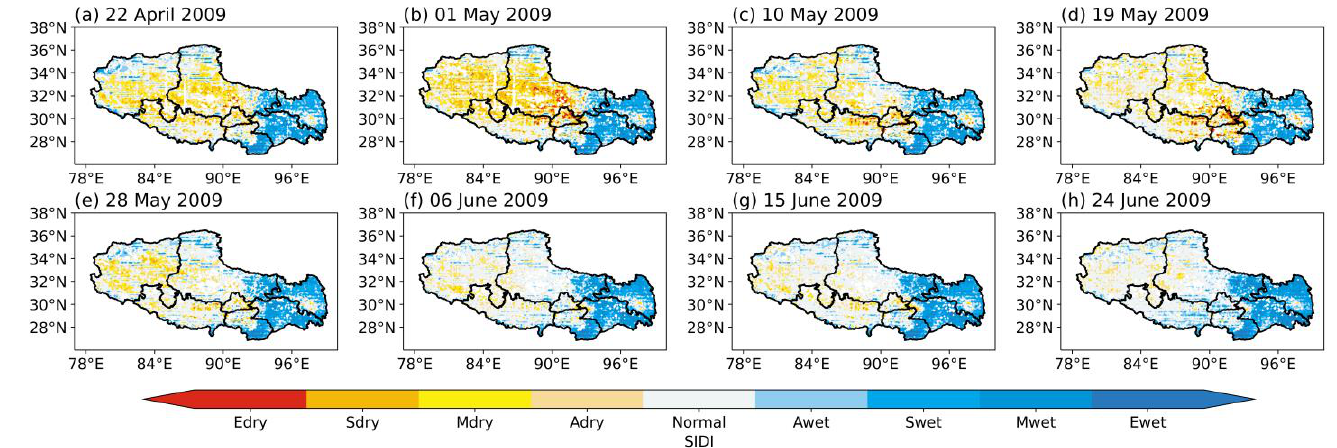
Figure 6. Spatial evolution characteristics of the drought process captured by the SIDI in the Xizang Autonomous Region from 22 April to 01 July 2009 at an interval of nine days: ( a ) 22 April 2009, ( b ) 01 May 2009, ( c ) 10 May 2009, ( d ) 19 May 2009, ( e ) 28 May 2009, ( f ) 06 June 2009, ( g ) 15 June 2009, and ( h ) 24 June 2009. Colors represent drought degree: the redder the color, the stronger the drought degree is.